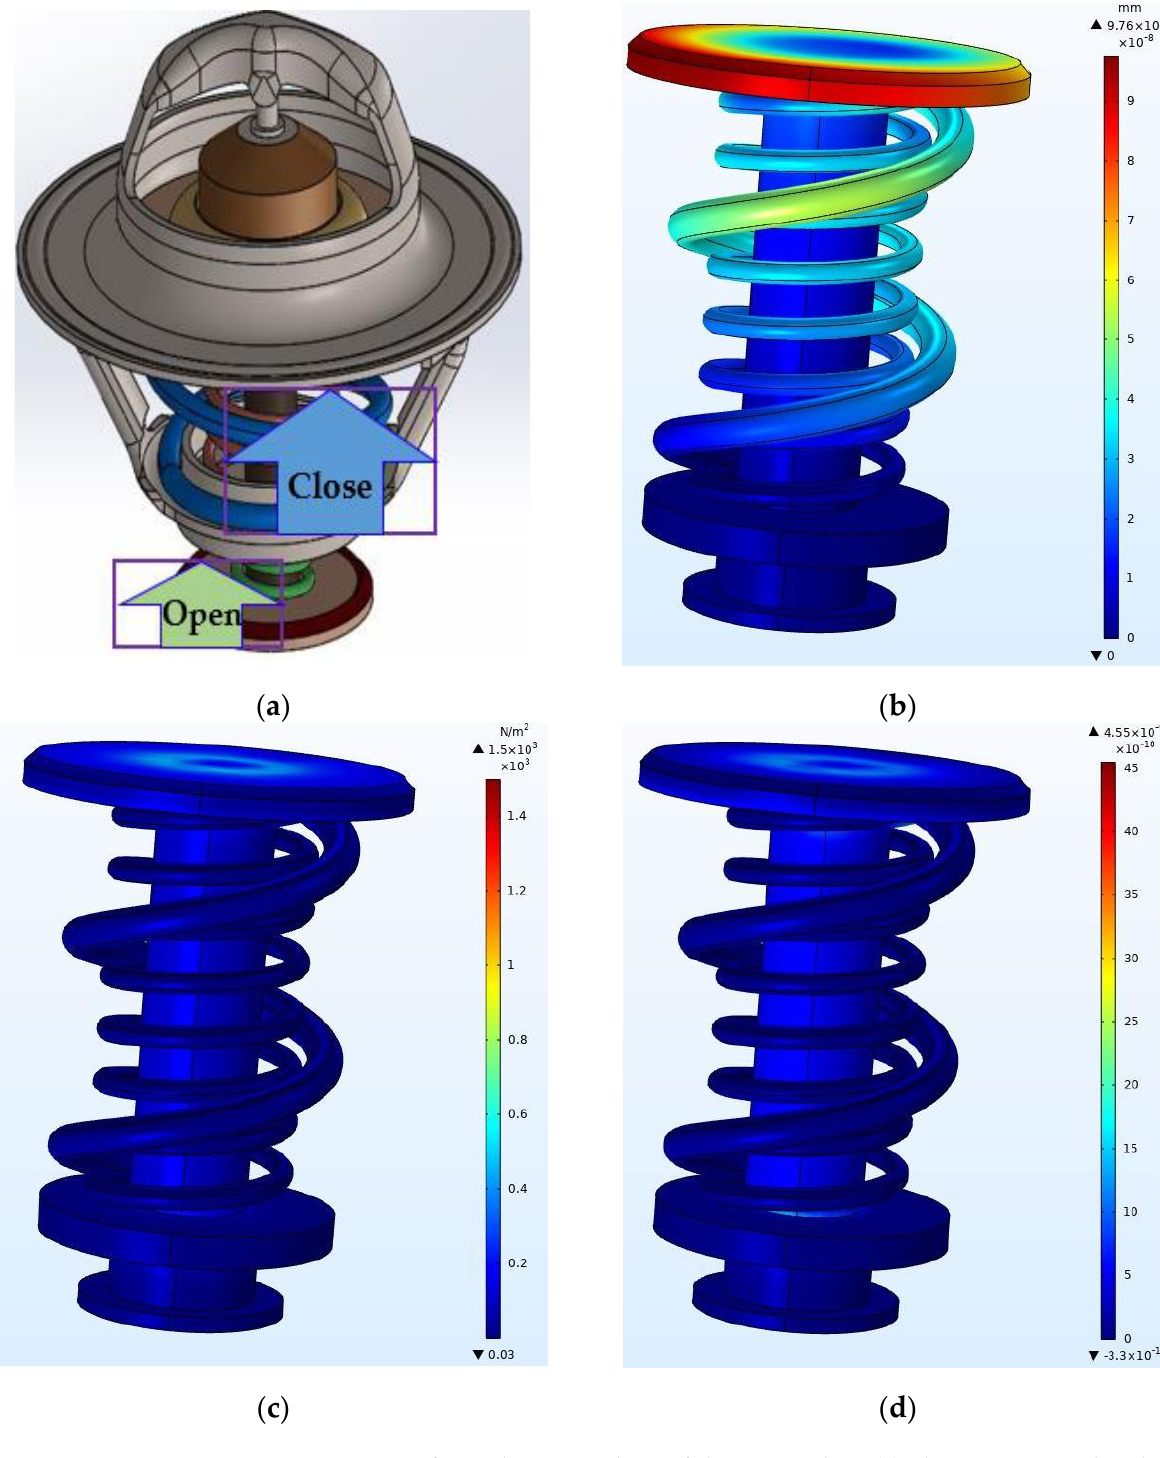
Figure 6. Static finite element analysis of the main valve. ( a ) Thermostat in a closed position, ( b ) displacements, ( c ) von Mises stresses, and ( d ) strain finite element model.